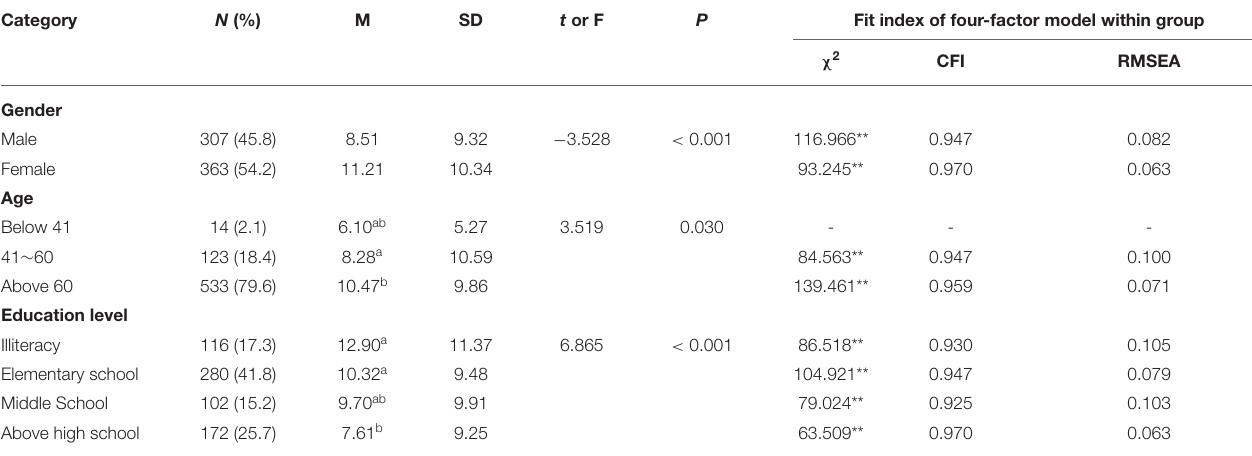
TABLE 1 | Score differences according to participants’ general characteristics. Category Fit index of four-factor model within group